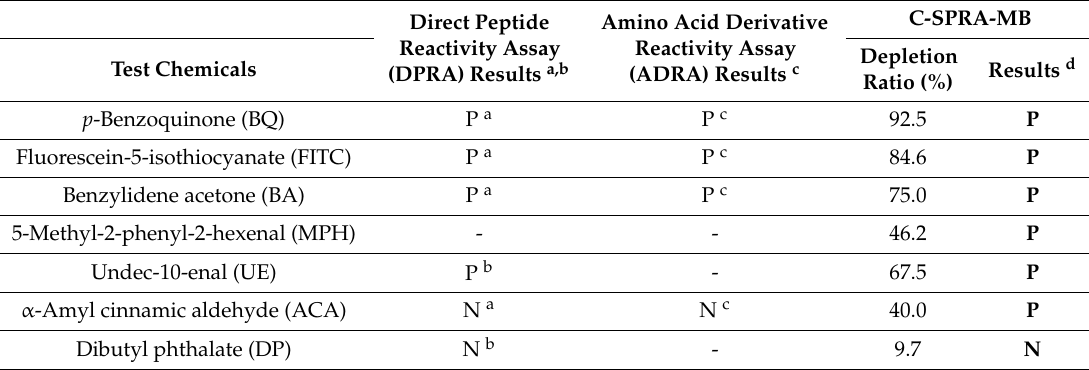
Table 1. Reactivity of 8 chemicals to Lys beads determined by percent depletion.